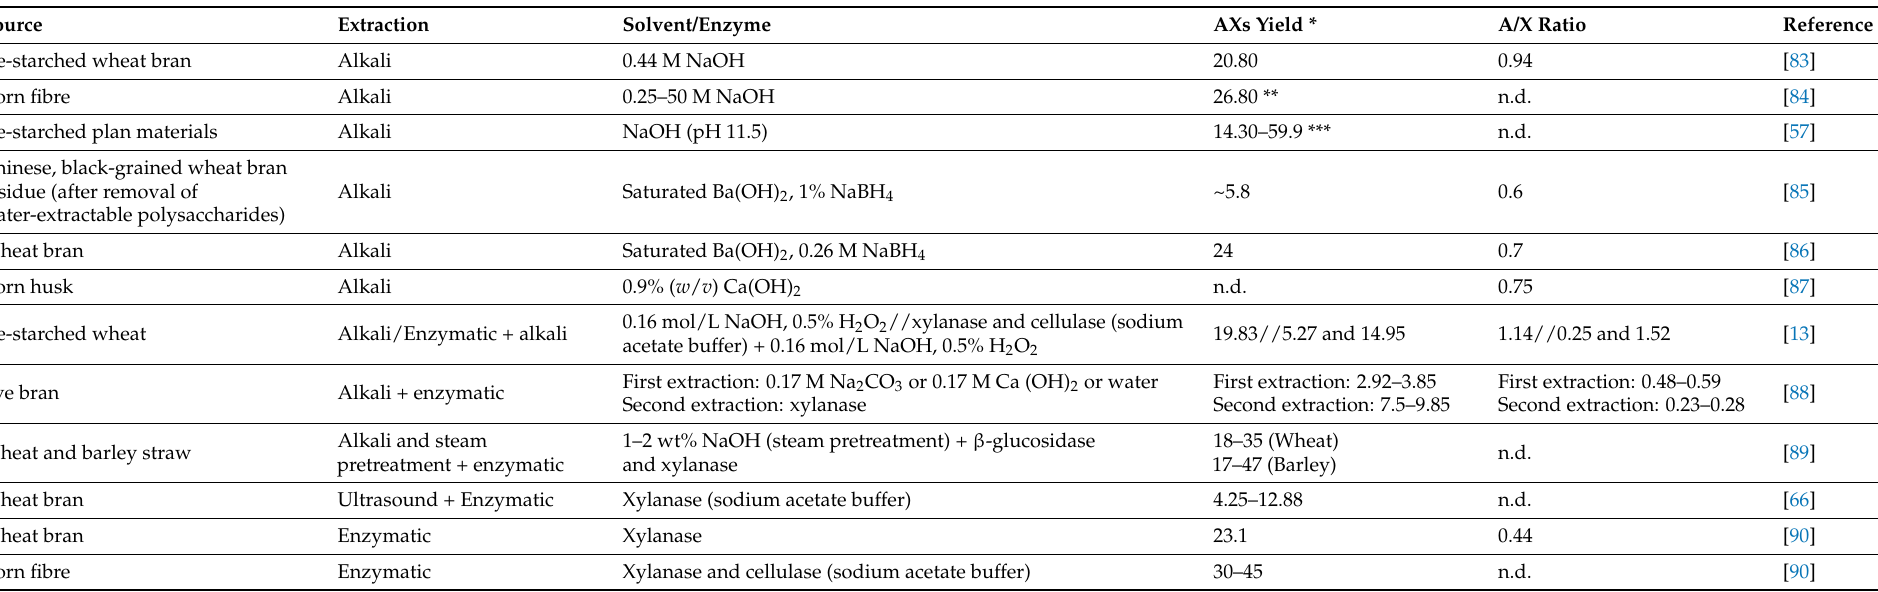
Table 2. Various arabinoxylans extraction procedures and